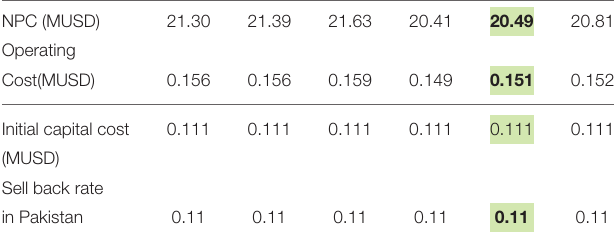
TABLE 4 | Optimization constraints in HOMER Software.